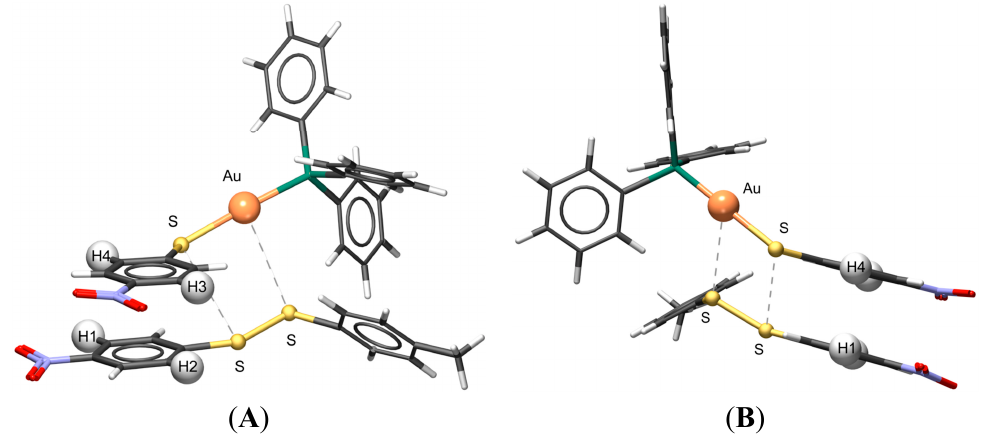
Figure 3. Cartoon drawings in two different views ( A and B ) to illustrate a possible orientation of Ph 3 PAu(SC 6 H 4 NO 2 ) and the unsymmetrical disulfide, CH 3 C 6 H 4 SSC 6 H 4 NO 2 . The distance between the aromatic protons, H 1 and H 4 , and H 2 and H 3 was set at 2.60 Å. The S…S and Au…S distances are 3.66 and 3.60 Å, respectively. The drawings were generated by using Autodesk 3DS MAX